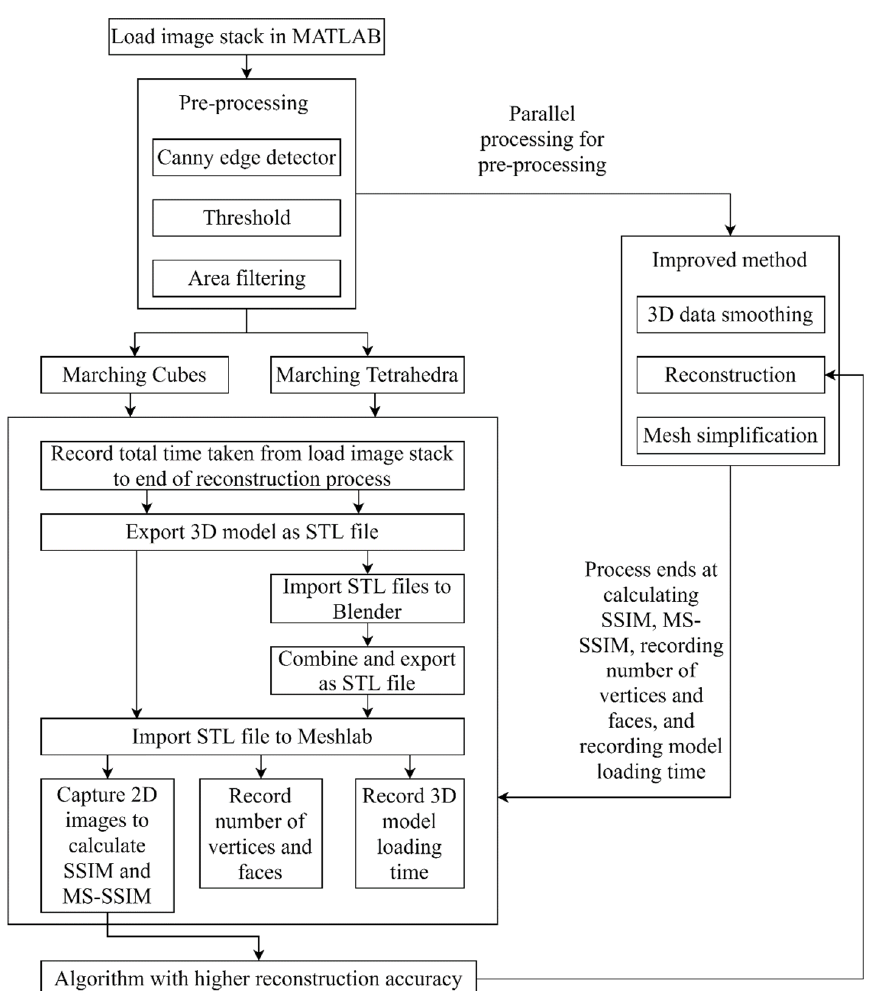
Figure 1. Overall flowchart of methodology.